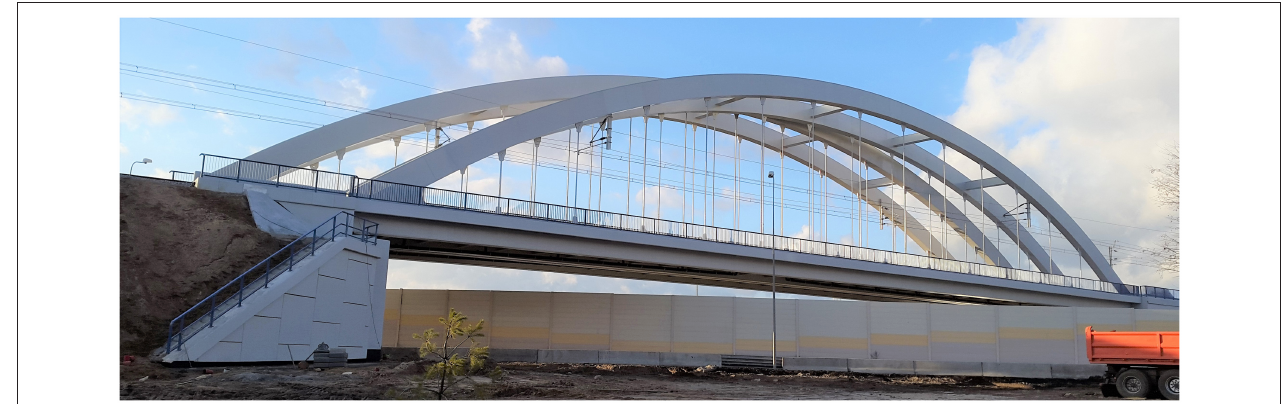
FIGURE 11 | Lateral view of the second railway bridge.